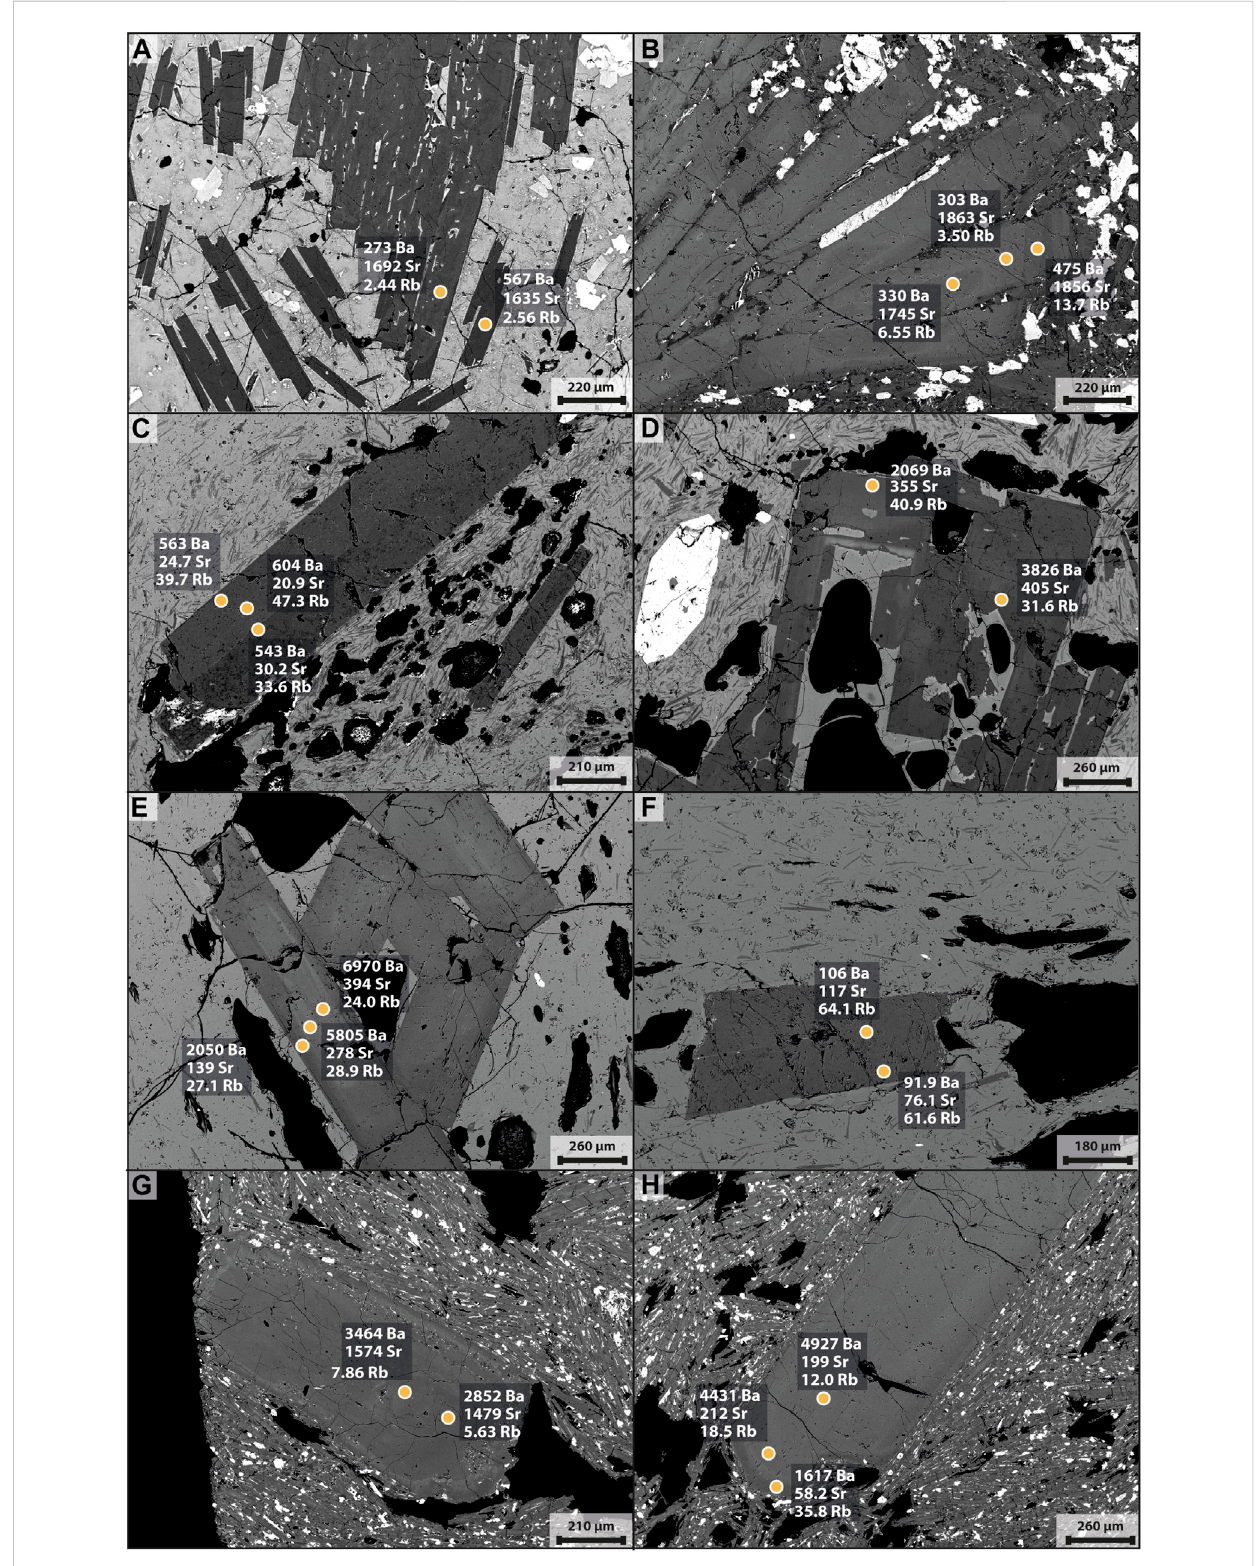
FIGURE 4 Back-scatteredelectron images showingrepresentative feldspars from Tenerife samples. Yellow circles represent spotsanalysed using LA-ICP-MS. Values for Ba, Sr, and Rb are also given next to the appropriate analysis point. (A) PV-C (B) PV-H (C) T-J2 (D) Lavas Negras (E) Arenas Blancas (F) Montaña Rajada (G, H) Montaña